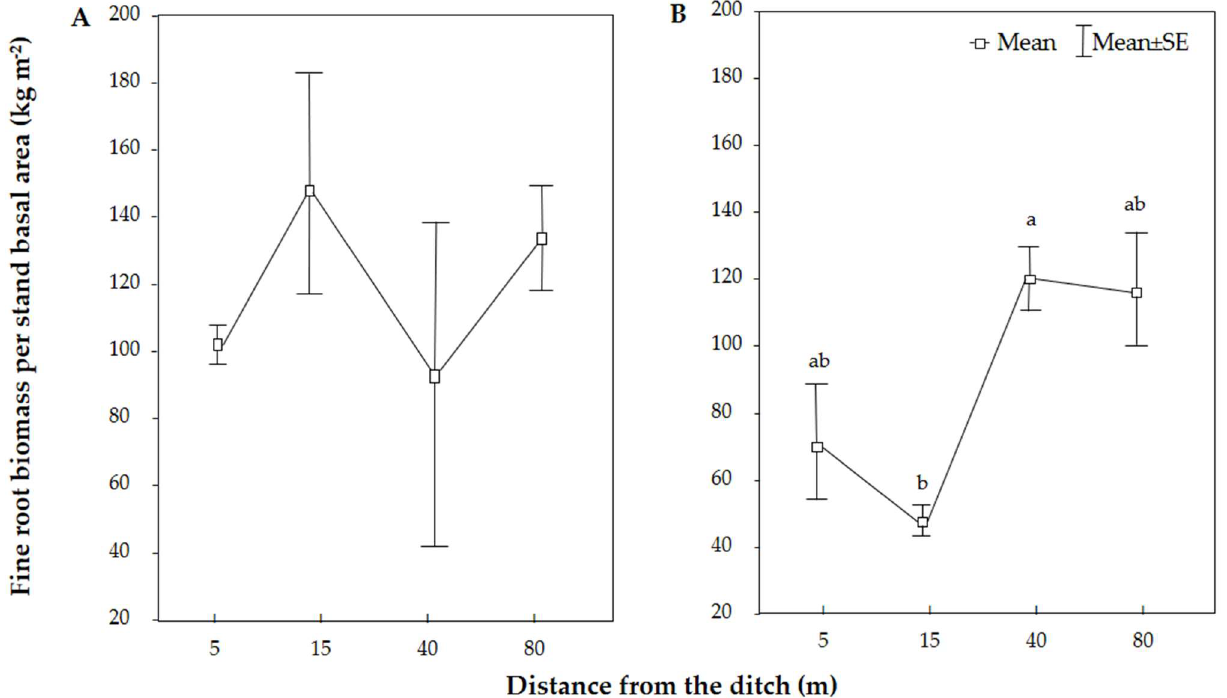
Figure 1. Means of the fine root biomass per stand basal area (FRB/BA, kg m − 2 ) with the standard error bars of three replicate stands per sampling plot at the distances of 5, 15, 40, and 80 m from the ditch in Downy birch ( A ) and Norway spruce ( B ). Small letters indicate a statistically significant difference (one-way ANOVA, followed by Tukey’s HSD; p < 0.05) of the mean spruce FRB/BA between four sampling plots.